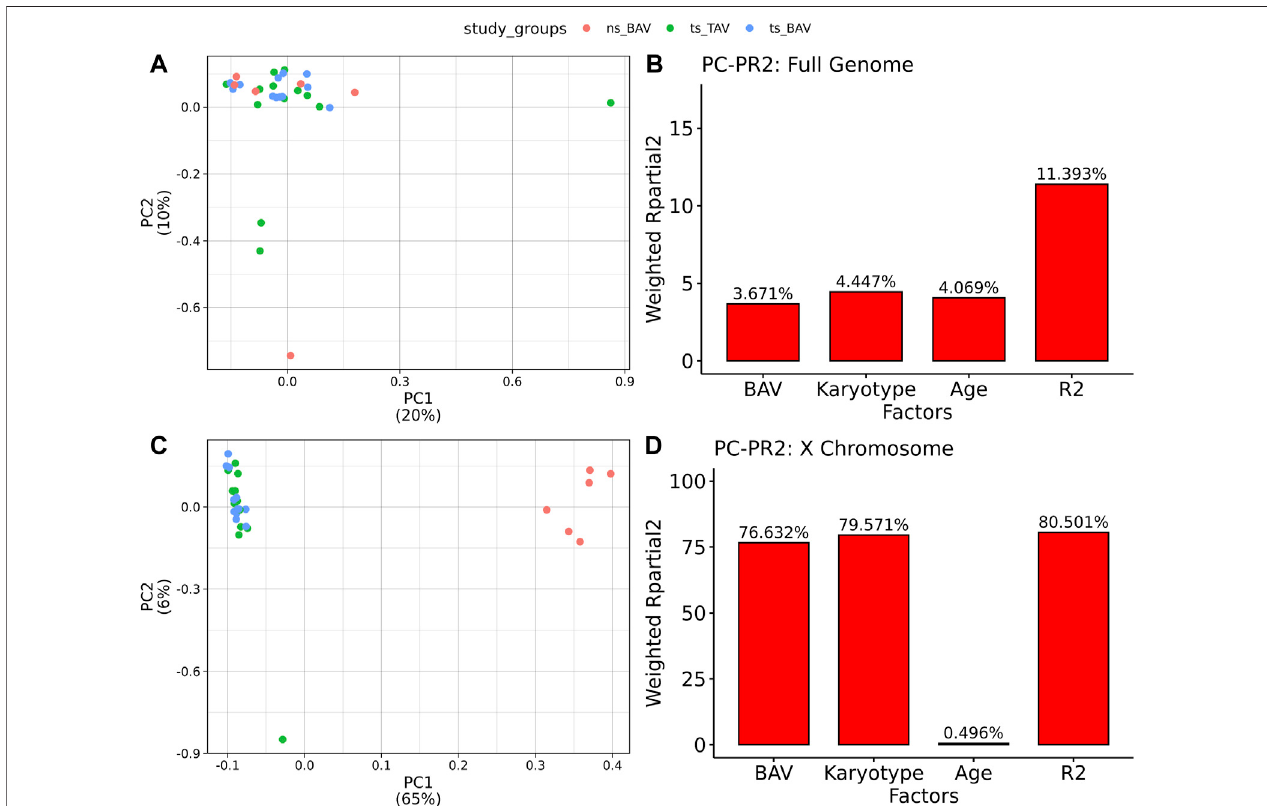
FIGURE 1 | Principal Components Analysis of Methylation data indicates TS samples are distinct from ns BAV on the X chromosome. (A) PCA biplot of fi rst 2 principal components for all autosomes. (B) PCPR2 analysis of biological variables for autosomes. (C) PCA biplot of X chromosome. (D) PCPR2 analysis of biological variables forthe X chromosome. Note, PCPR2issensitivetomulticollinearity and overestimates BAV contribution due tounbalancedrepresentationfor each